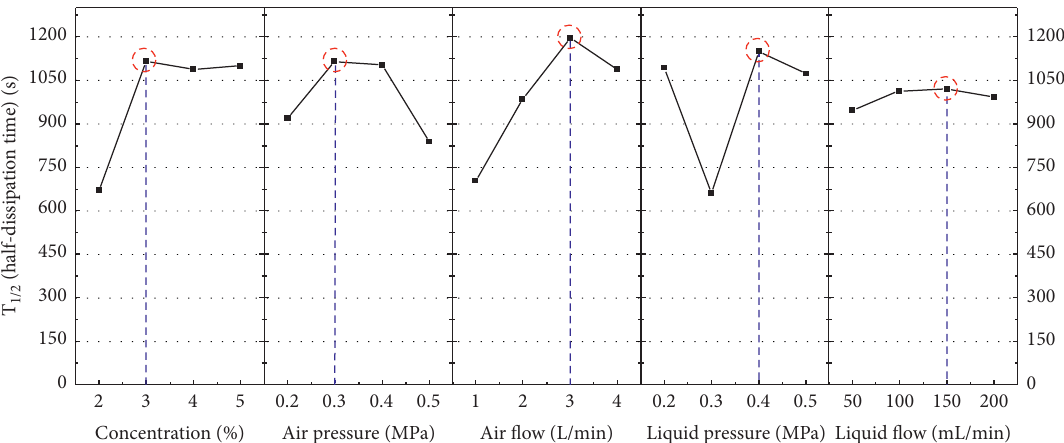
Figure 11: Effect of foaming parameters on half-dissipation time.